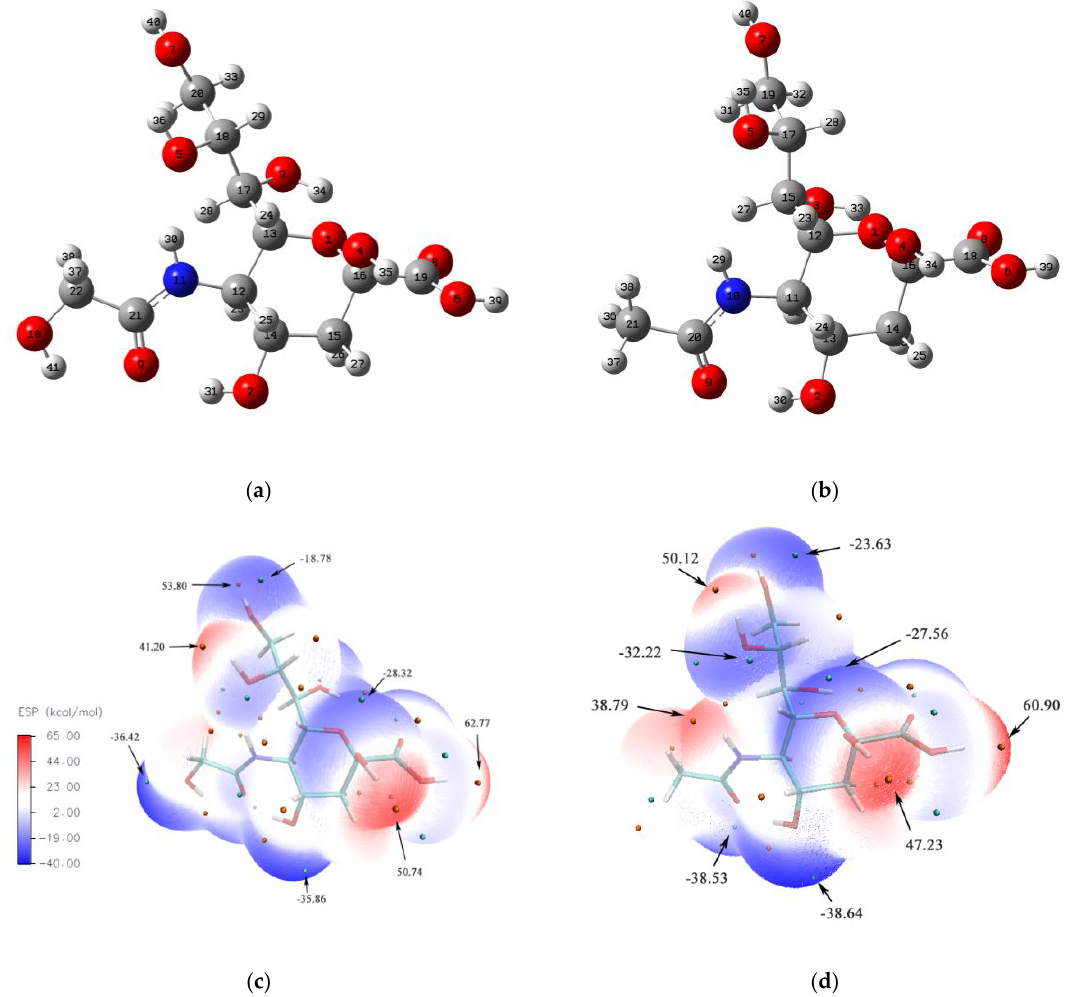
Figure 1. The gas phase optimized structure and molecular electrostatic potential (ESP) of Neu5Gc and Neu5Ac. Note: ( a ) The optimized structure of Neu5Gc, ( b ) The optimized structure of Neu5Ac, ( c ) The ESP of Neu5Gc, ( d ) The ESP of Neu5Ac. Unit: kcal/mol.